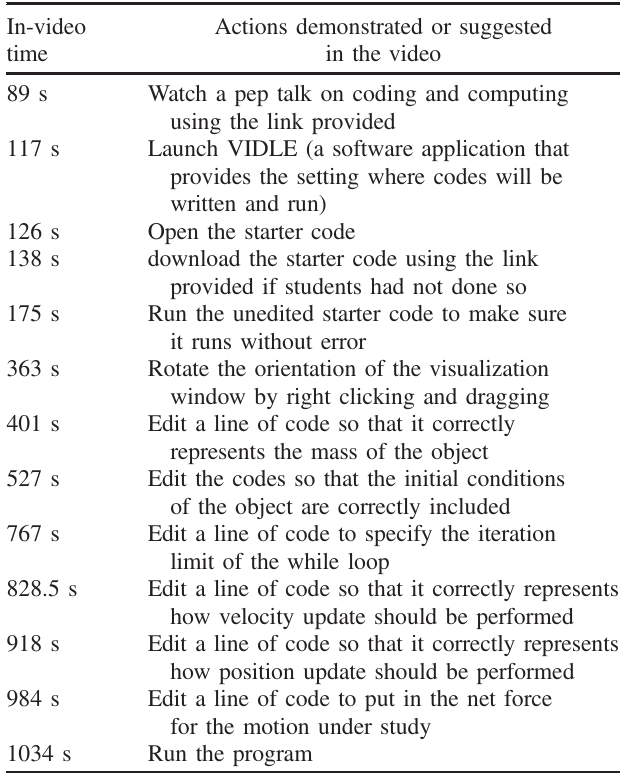
TABLE VI. Description of the action each arrow represented in Fig.